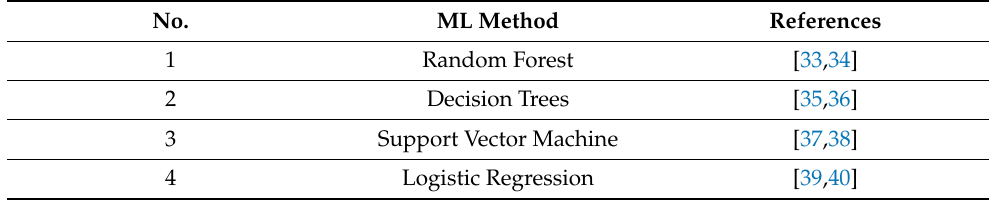
Table 1. Summary of traditional machine learning (ML)